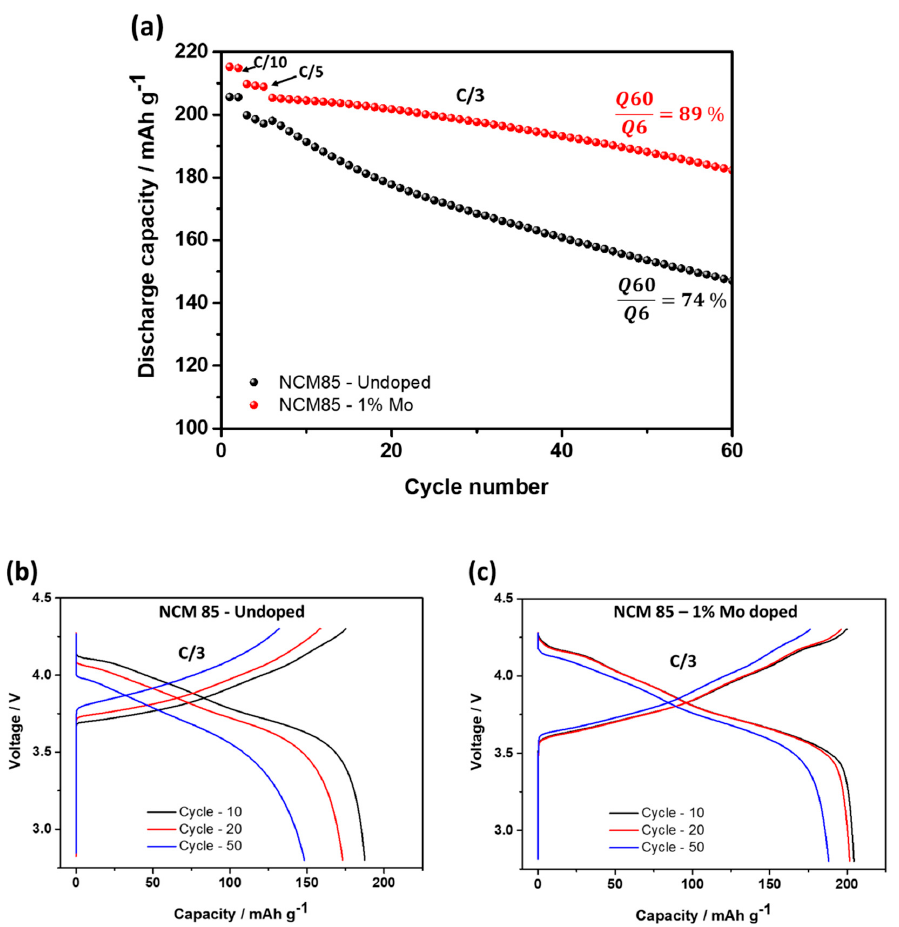
Figure 6. ( a ) Cycling behavior of electrodes comprising undoped and 1 at. % Mo-doped NCM85 materials, at 30 °C. Indicated are C-rates used and the capacity retention values measured for cycles 6-th and 60-th; ( b , c ) Voltage profiles of the above electrodes registered during charge/discharge in cycles 10-th, 20-th and 50-th at a C/3 rate. They show higher capacities obtained from Mo-doped NCM85 as well as more reversible phase transitions at ~4.2 V of these electrodes compared to the undoped ones.